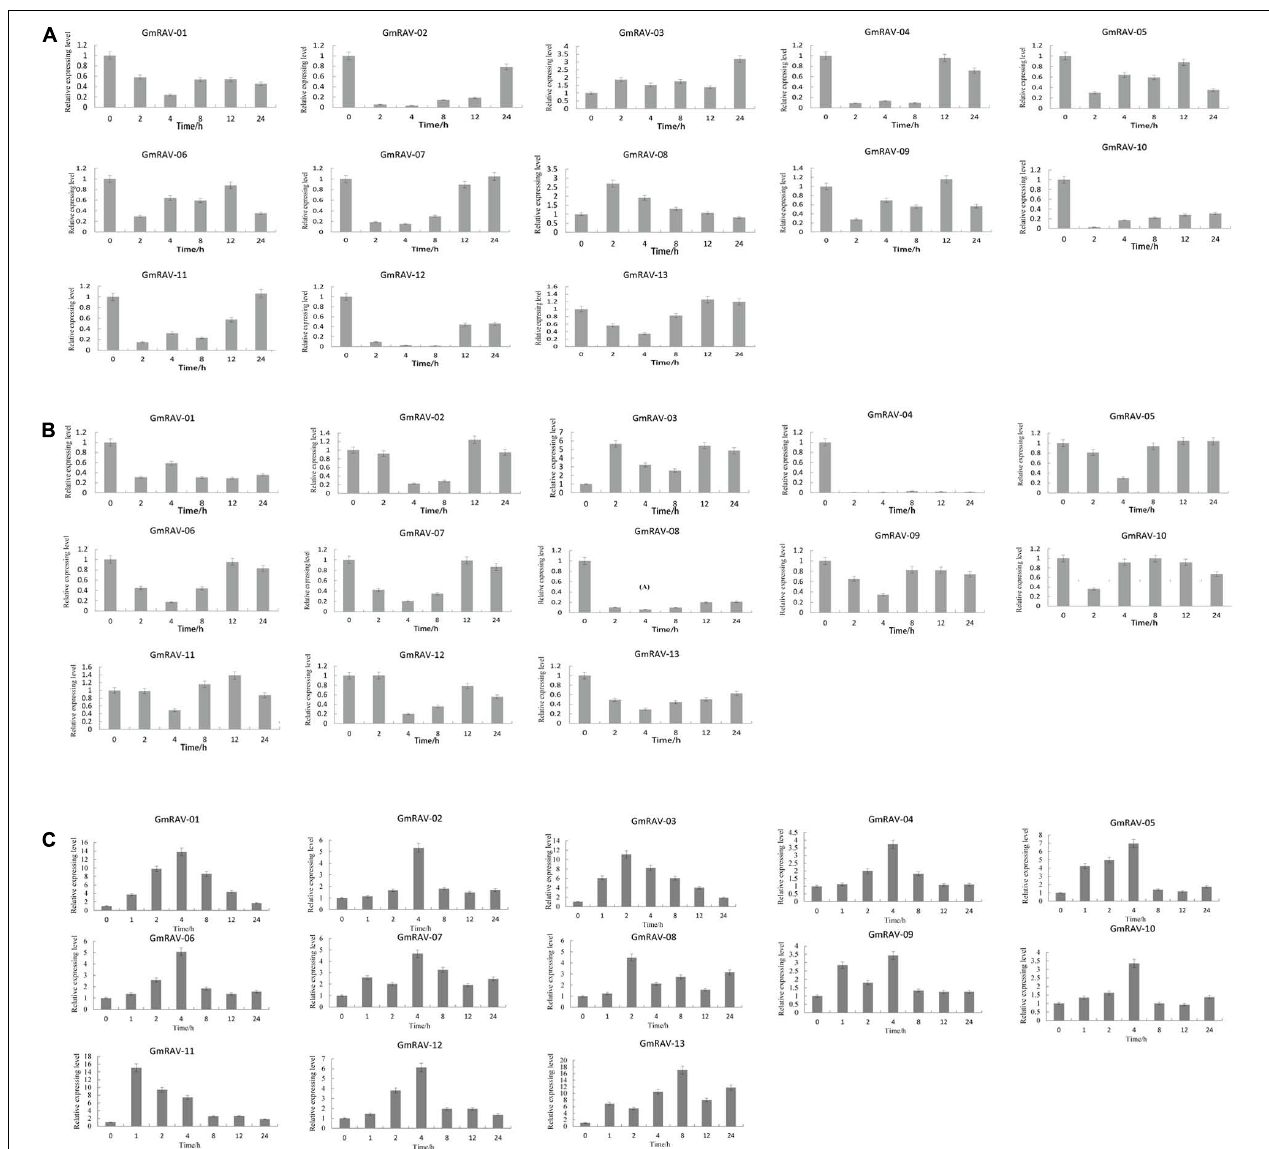
FIGURE 7 | Relative expression of soybean RAV genes in plants treated with drought, NaCl, and exogenous application of ABA. qRT-PCR analyses of plants treated with drought (A) , NaCl (B), and ABA (C) .